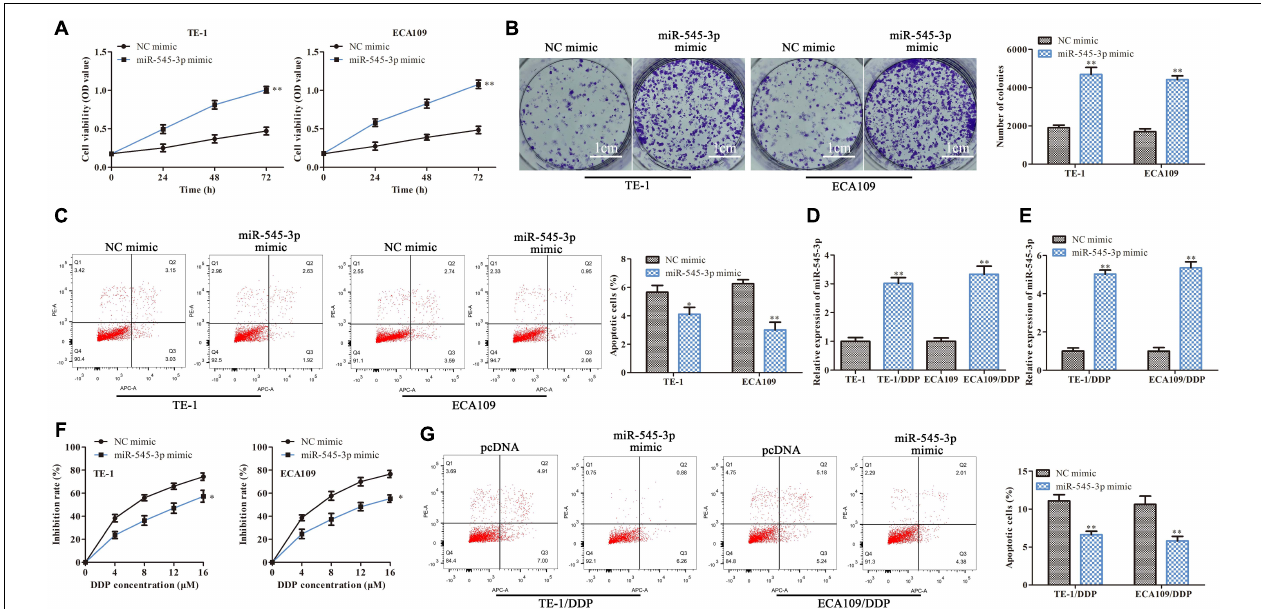
FIGURE 5 | MiR-545-3p promotes the proliferation and enhances DDP resistance in ESCC cells. TE-1, ECA109, TE-1/DDP, and ECA109/DDP were transfected with miR-545-3p mimics and NC mimics. (A) The proliferation assessed by CCK-8 assay. (B) The proliferation measured by clone formation assay. (C) The apoptotic cell detected by flow cytometry assay. (D) The expression of miR-545-3p in TE-1, TE-1/DPP, ECA109, and ECA109/DDP cells. (E) The expression of miR-545-3p in TE-1/DPP and ECA109/DDP cells. (F) The proliferation inhibition rate assessed by CCK-8 assay. (G) The apoptotic cell detected by flow cytometry assay. * P < 0.05, ** P < 0.01 compared with the corresponding control